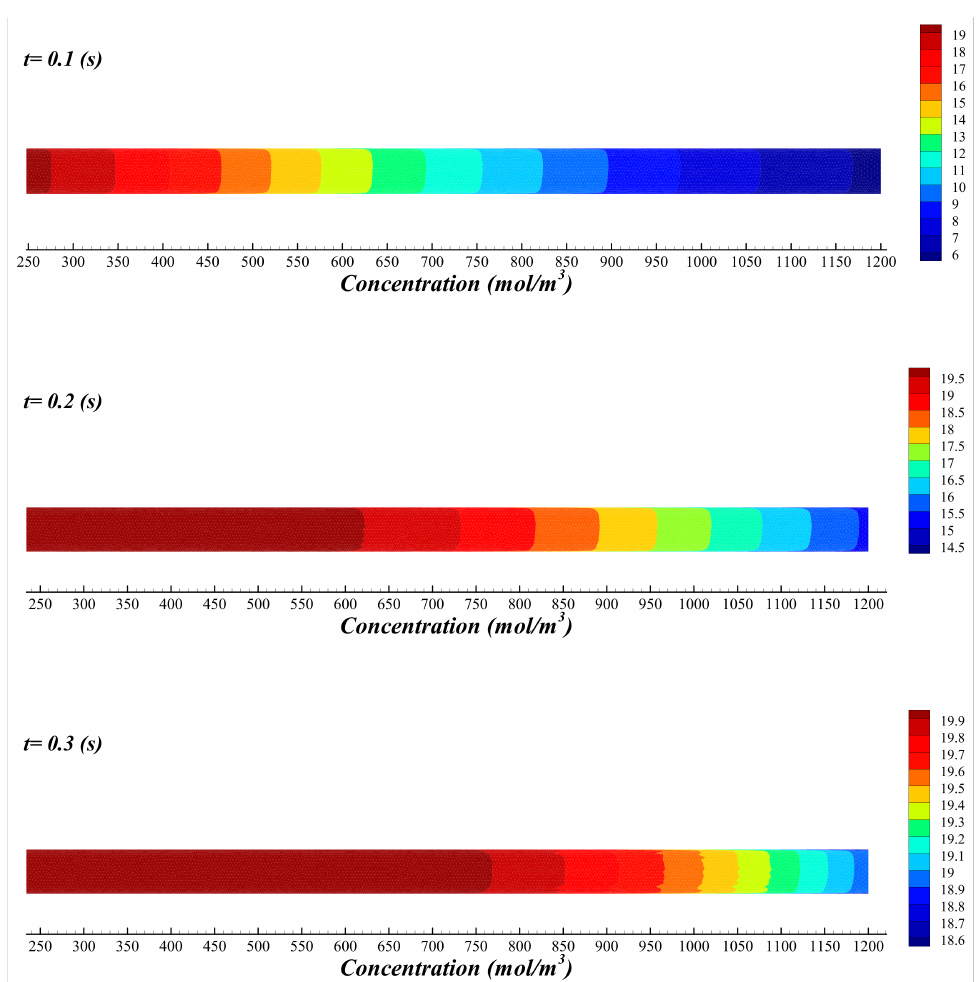
Figure 11. The contours of concentration in the porous collector at the three different time steps for a low porosity of